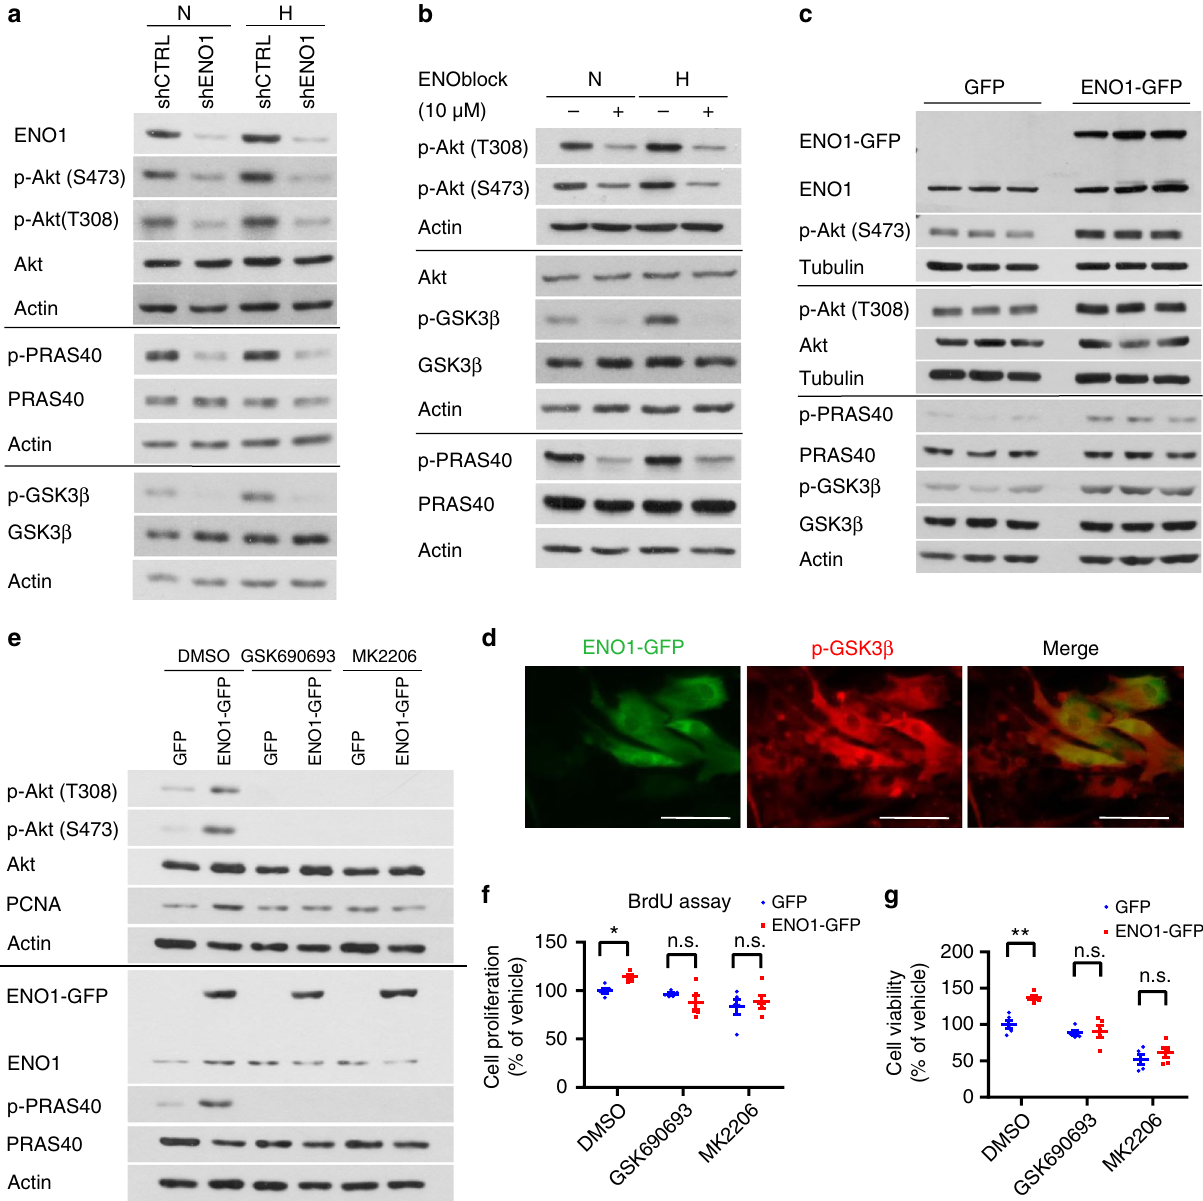
Fig. 4 ENO1 promotes PASMC proliferation via the activation of the Akt-GSK3 β pathway. a We treated shENO1 and shCTRL PASMC with hypoxia (1% O 2 ) for 8 h, and measured the levels of p-Akt, pan-Akt, p-PRAS40, PRAS40, p-GSK3 β , and GSK3 β by western blotting. b Normal PASMCs were treated with 10 μ M ENOblock and hypoxia for 8 h, and the levels of p-Akt, pan-Akt, p-PRAS40, PRAS40, p-GSK3 β , and GSK3 β were measured by western blotting. c PASMCs were transfected with pCMV3-ENO1-GFP, and afterwards we measured the level of p-Akt, pan-Akt, p-PRAS40, PRAS40, p-GSK3 β , and GSK3 β using western blotting . d PASMCs were transfected with pCMV3-ENO1-GFP and immunostained with antibody against p-GSK3 β . The green fl uorescence indicates the GFP-tagged ENO1 and the red fl uorescence indicates p-GSK3 β (Scale bars, 50 μ m). e PASMC were transfected with pCMV3-ENO1-GFP and treated with 1 μ M GSK690693 or MK2206 for 12 h. The level of p-Akt, pan-Akt, and PCNA were measured by western blotting in the cell lysate. We also measured the f cell proliferation (using BrdU assay) and g cell viability in ENO1-overexpressing PASMC after the treatment of two Akt